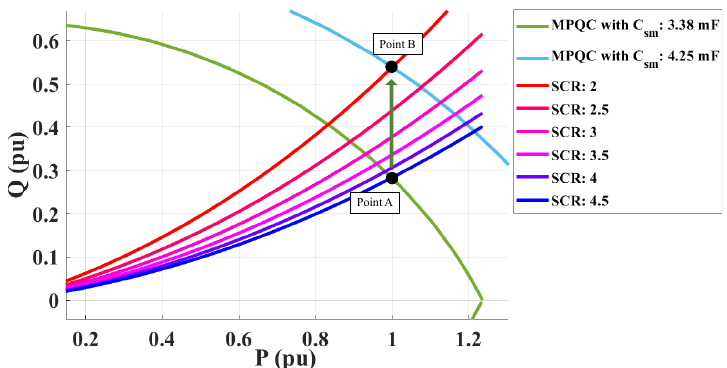
Figure 12. Different PQ loading curves of MMC in MILM under different short circuit ratio.